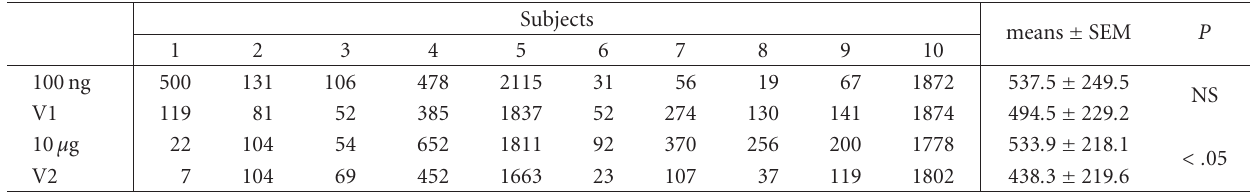
Table 1: Amounts of IL-6 released from whole blood obtained from healthy men following incubation with 100 ng or 10 μ g of β -hydroxy lauric acid for 24 hours ( n = 10, V; vehicle). Results were expressed as pg/mL (compared to vehicle, NS; not significant).